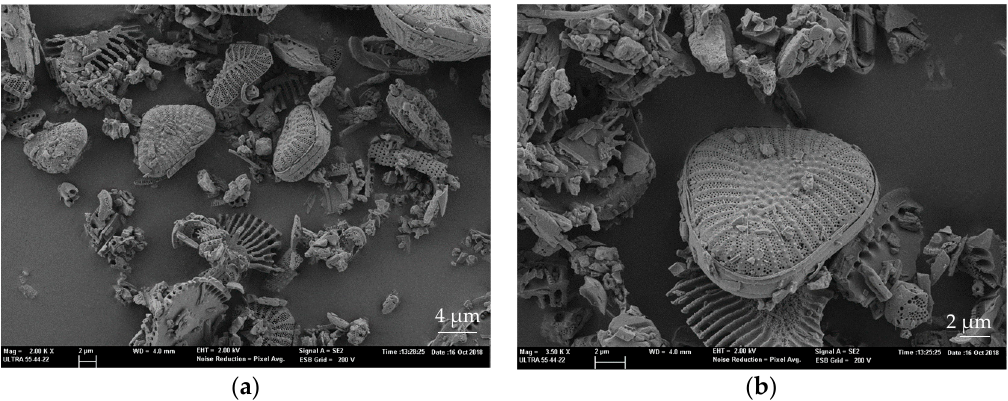
Figure 2. FESEM images of diatomaceous earth at di ff erent magnification ( a ) 2000 × and ( b ) triangular Figure 1. FESEM images of diatomaceous earth at different magnification ( a ) 2000× and ( b ) triangular shape detail at 3500 × shape detail at 3500×.